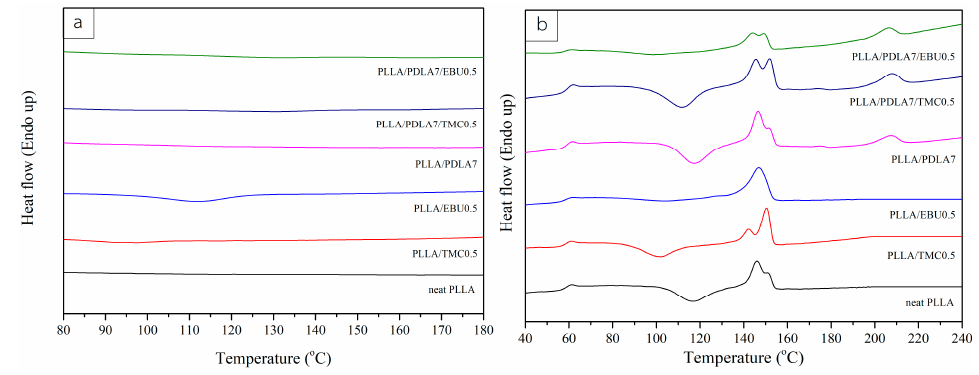
Figure 4. DSC cooling scan ( a ) and DSC second heating scan ( b ) of nucleated PLLA.